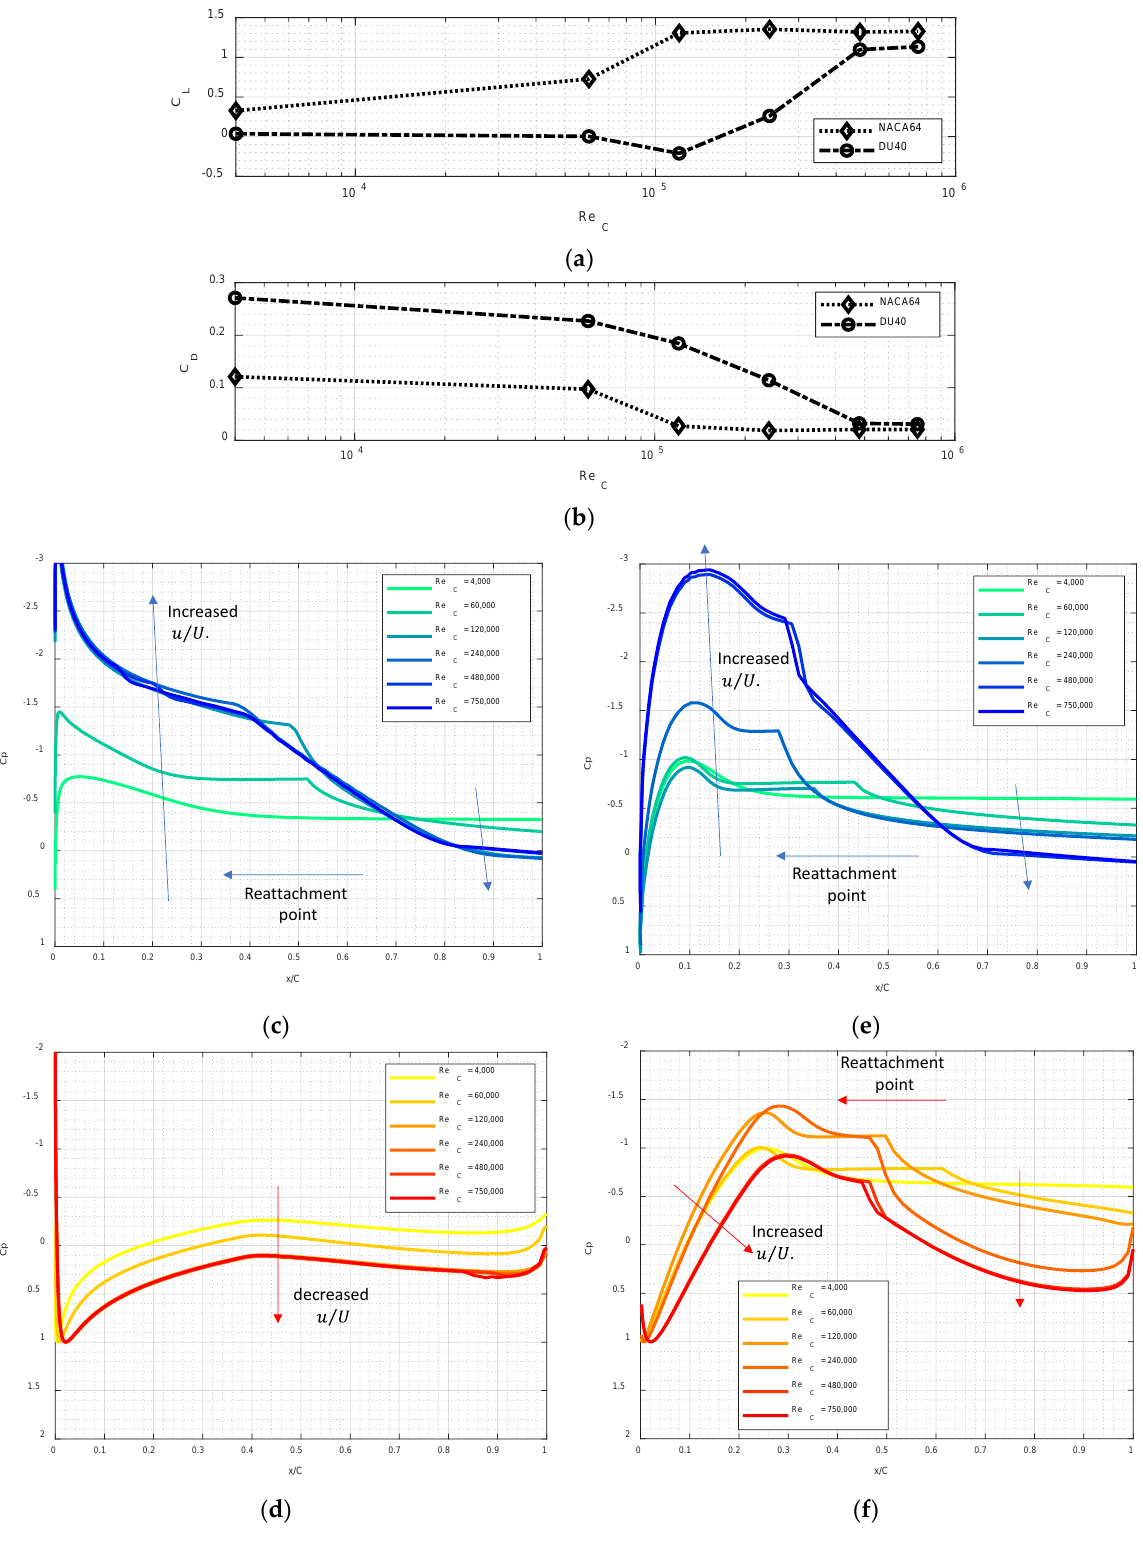
and Rec = 4000, 60,000, α = 10°